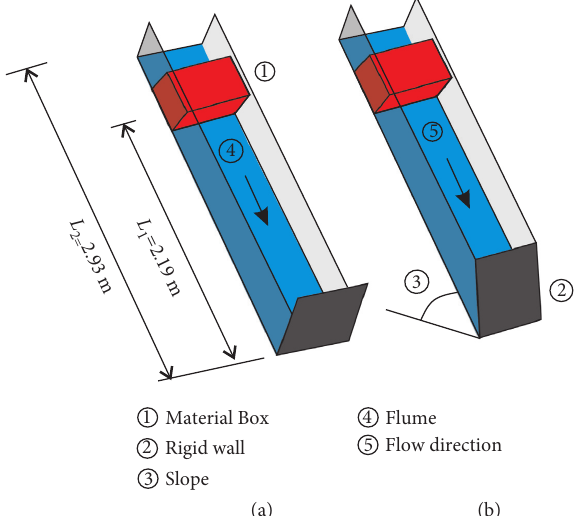
Figure 5: Sketch of the experimental flume: (a) tilted rigid wall and (b) vertical rigid wall.